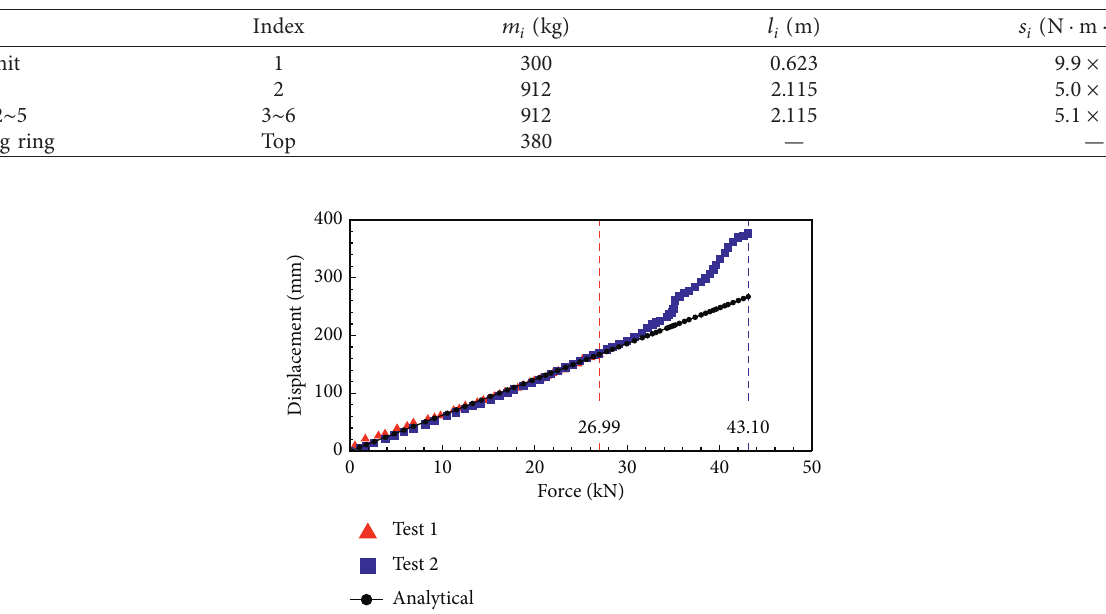
Table 2: Multibody model parameters of the porcelain arrester specimen.